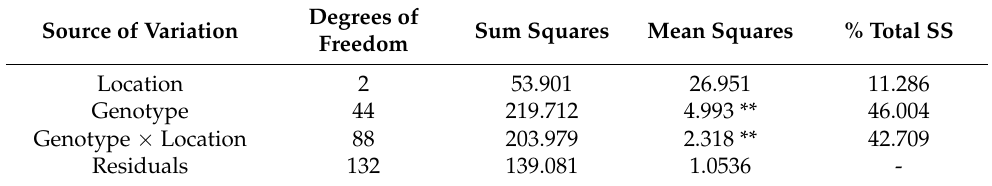
Table 7. Genotype–location interaction ANOVA for grain yield studied at three